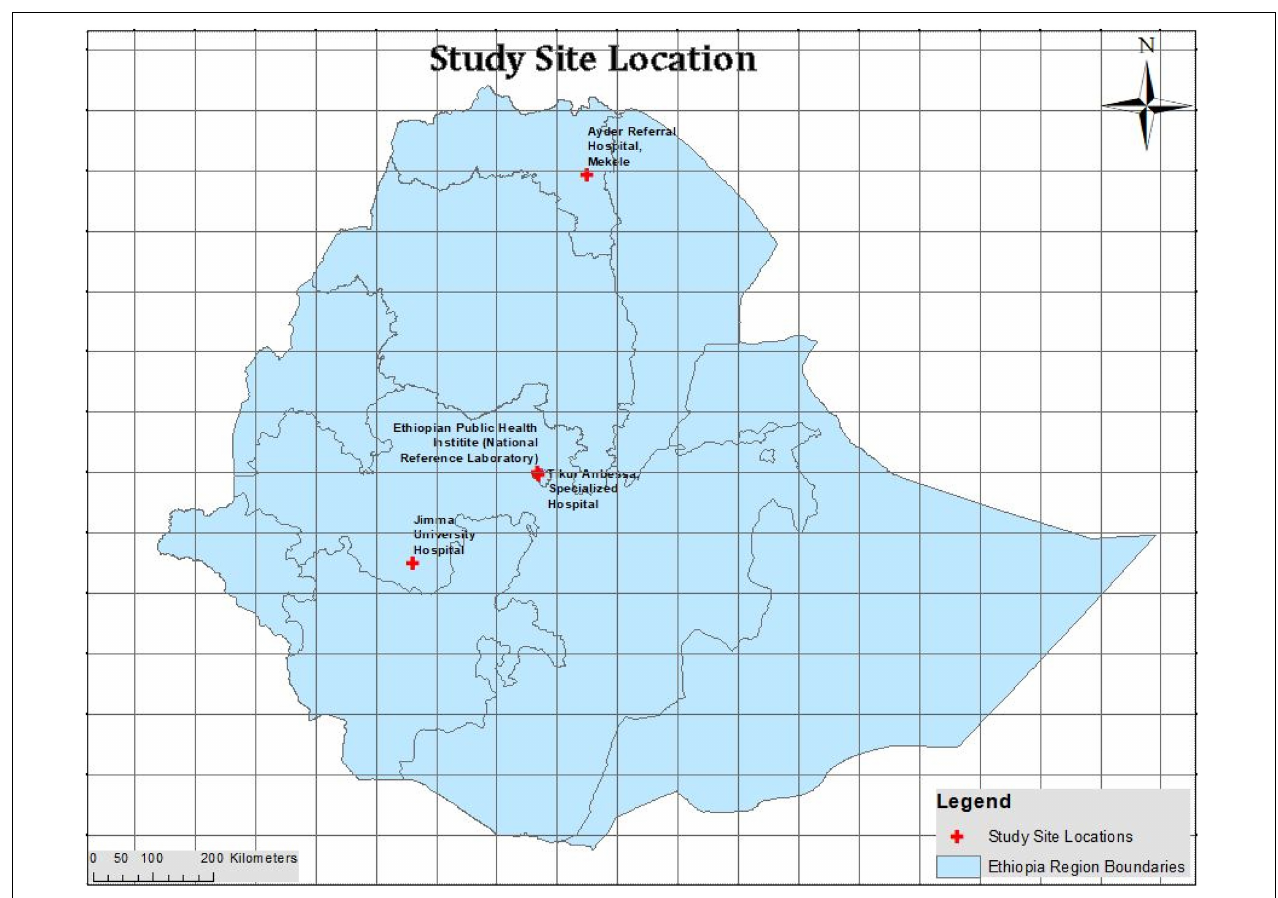
FIGURE 1 | The four health facility sites engaged in this study and from where the isolates were obtained. The National reference laboratory and Tikur Abessa specialized hospital are located in the capital city, Addis Ababa. The Ayder referral hospital is situated in Mekele City in northern Ethiopia. The Jimma University Hospital lies in Jimma City, located in the south west of